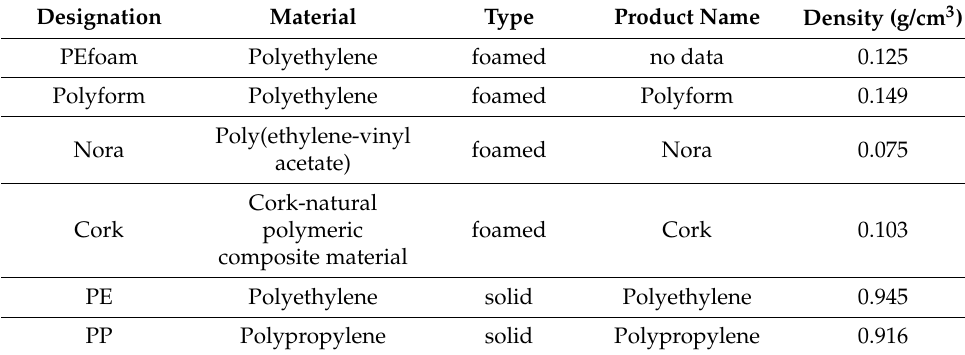
Table 1. List of materials